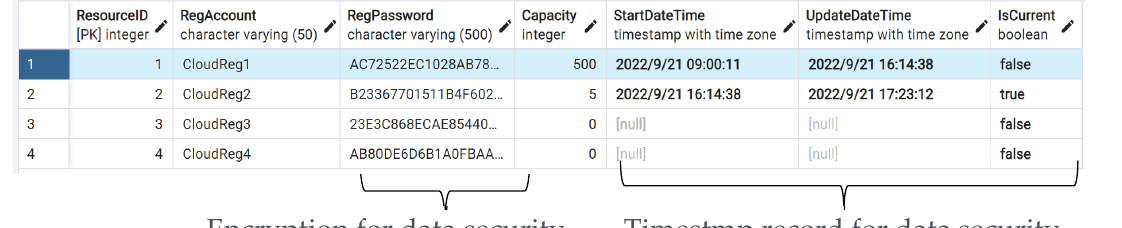
Figure 10. The results of the resource pool.